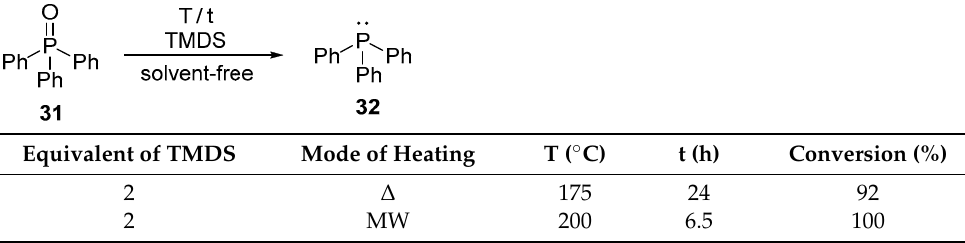
Table 11. Deoxygenation of triphenylphosphine oxide ( 31 ) using TMDS in the absence of catalysts.